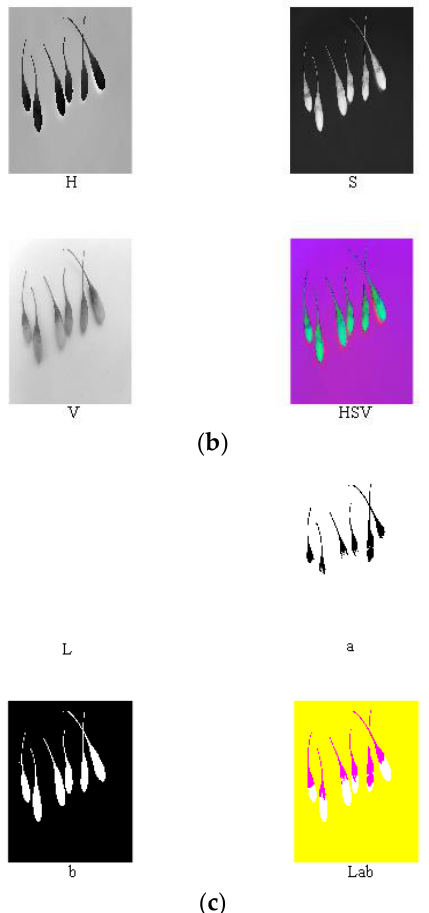
Figure 5. Extraction process of RGB ( a ), HSV ( b ), and lab ( c ) of the half-ripe fruit.